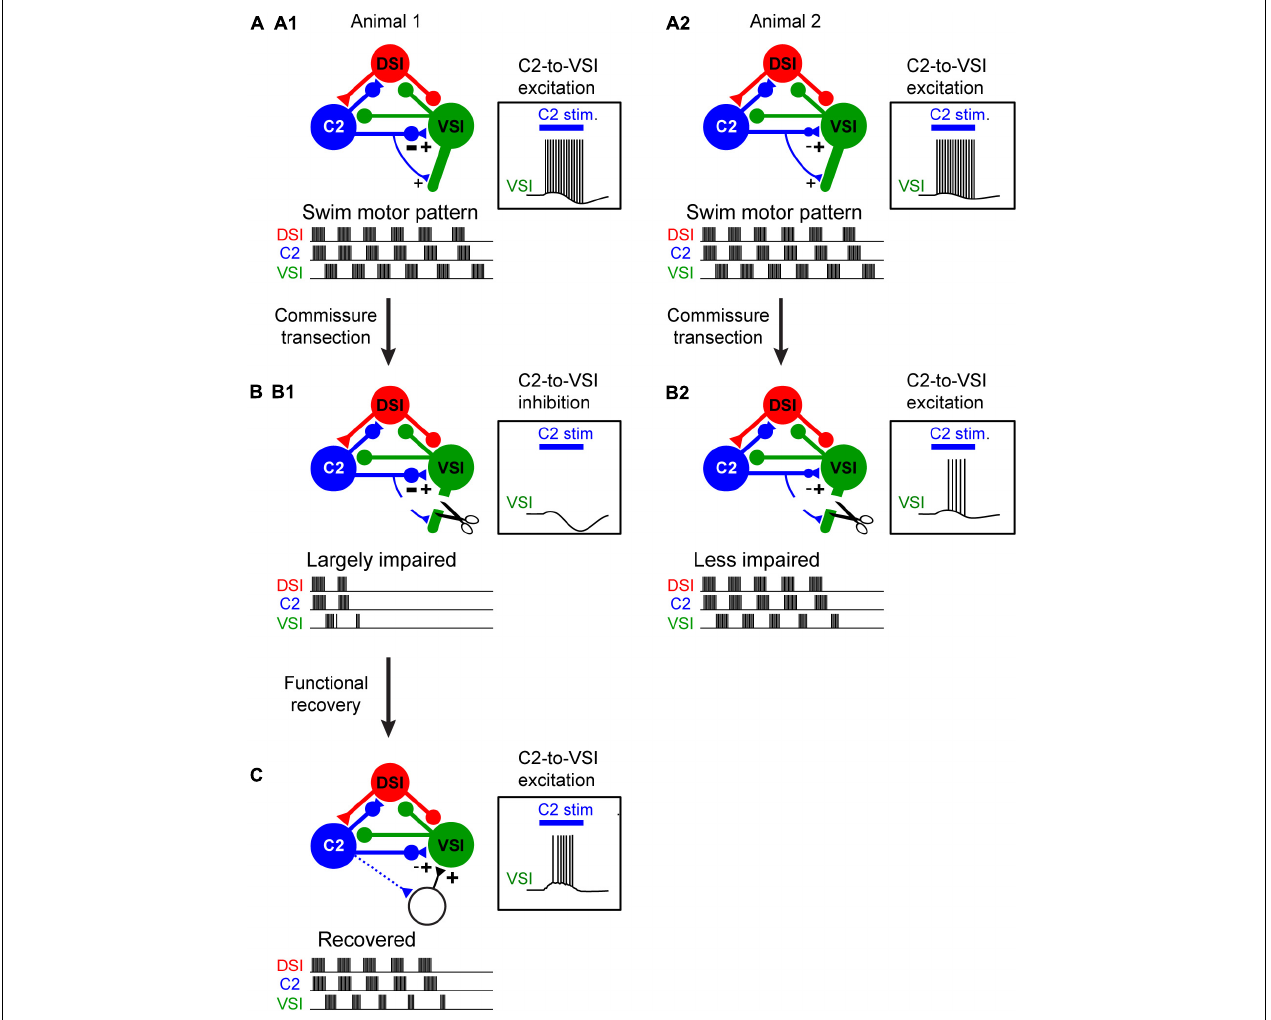
FIGURE 2 | The extent of injury-induced impairment in the swim motor pattern depends on the strength of a particular synapse. (A1,A2) Schematic illustration of differences in synaptic strength and motor output under normal conditions. Animal 1 (A1) and Animal 2 (A2) exhibit no apparent difference in the swim motor pattern. C2 synapses on VSI proximally and distally. The two animals differ in the strength of the proximal inhibition. But this has no effect on the ability of C2 stimulation (blue bar) to elicit a spike train in VSI. (B1,B2) When the distal synapse from C2 to DSI is cut, the motor pattern in Animal 1 is impaired because the proximal synapse had a strong inhibitory component and C2 fails to excite VSI (B1). However, the motor pattern in Animal 2 is less impaired because the proximal synapse was less inhibitory so C2 continues to excite VSI (B2). (C) Injury-induced loss of swim motor pattern is restored within a few hours by the recruitment of unidentified neurons with excitatory synapses to VSI (dotted lines). This recovery also involves the serotonergic DSIs (not